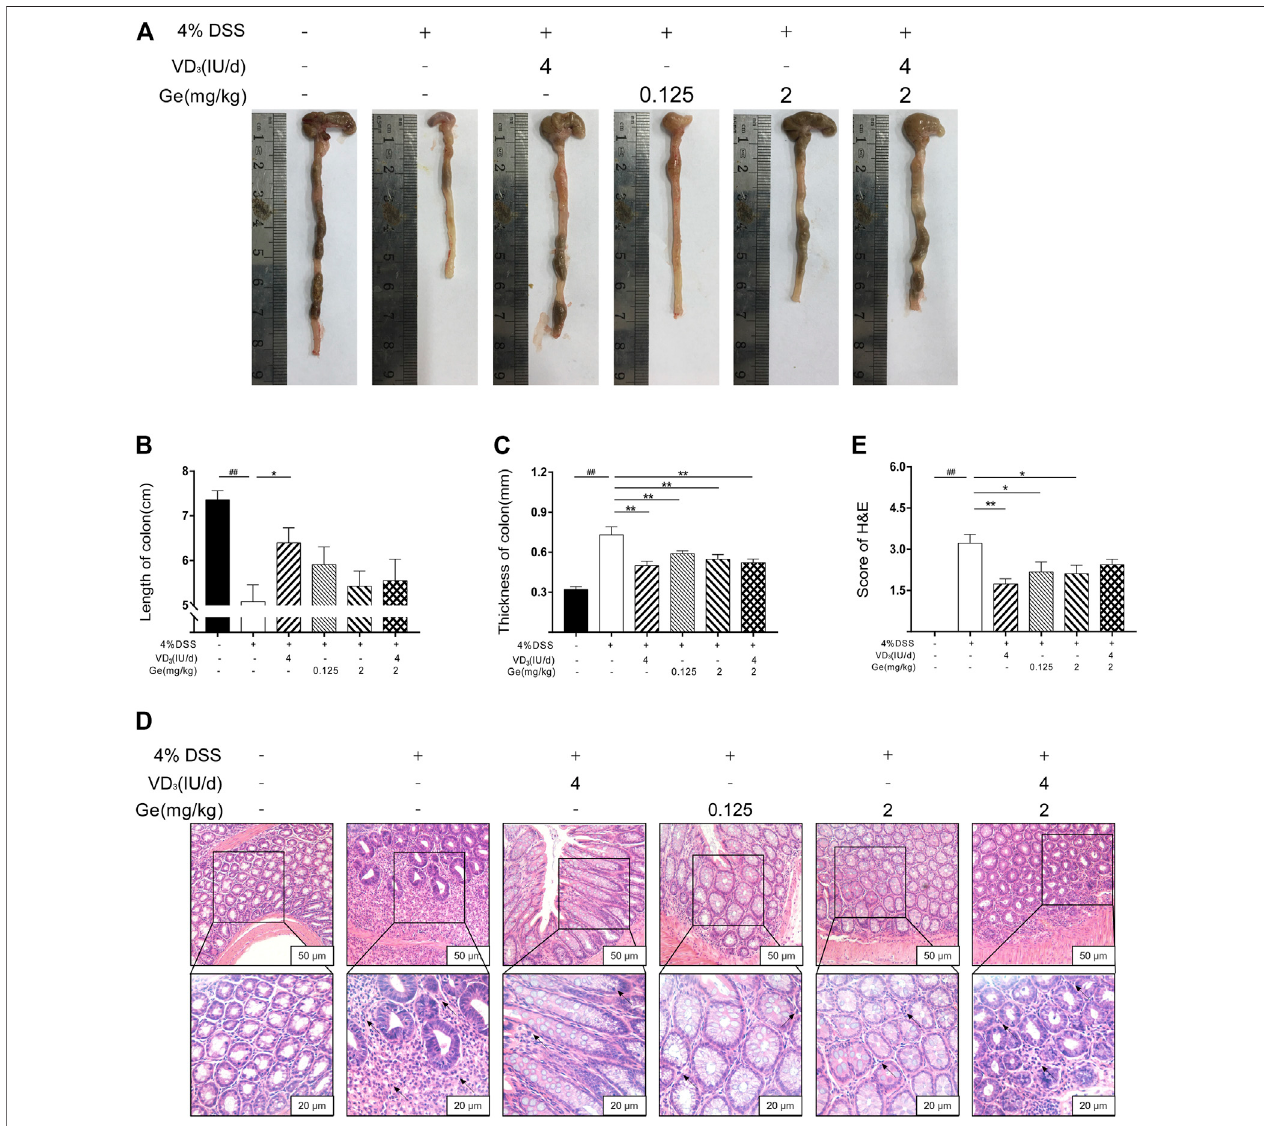
FIGURE 2 | Combination of vitamin D 3 and geniposide could not improve the length of colon in UC mice. (A) Representative colon of each group. (B) Length of colon. (C) Thicknessofcolon. (D) Representativecolonictissueofeachgroup(200 × and400 × ). (E) H&Escore. ## p < 0.01,vs.thenormalcontrolgroup;* p < 0.05,** p < 0.01, vs. the model control group. n (cid:1) 11 per each